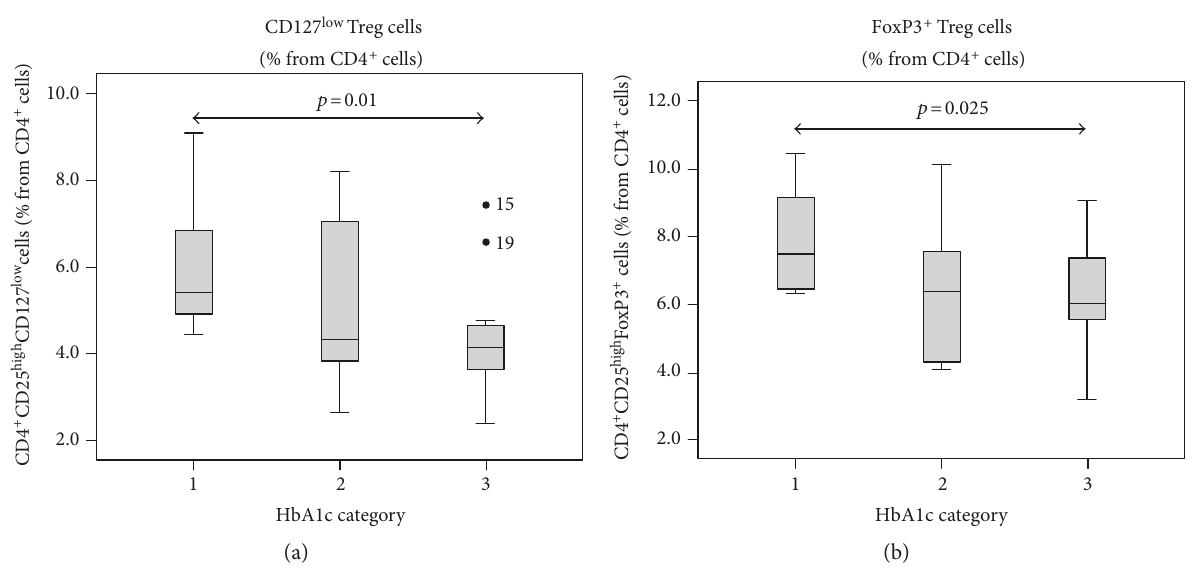
Figure 4: T regulatory cells and HbA1c category. The lowest count of Treg cells was determined in the group of patients with poor diabetes stabilization with the highest HbA1c levels (category 3) and di ff ered signi fi cantly from that with the lowest HbA1c, independently whether Treg marker CD127 low or FoxP3 was used.